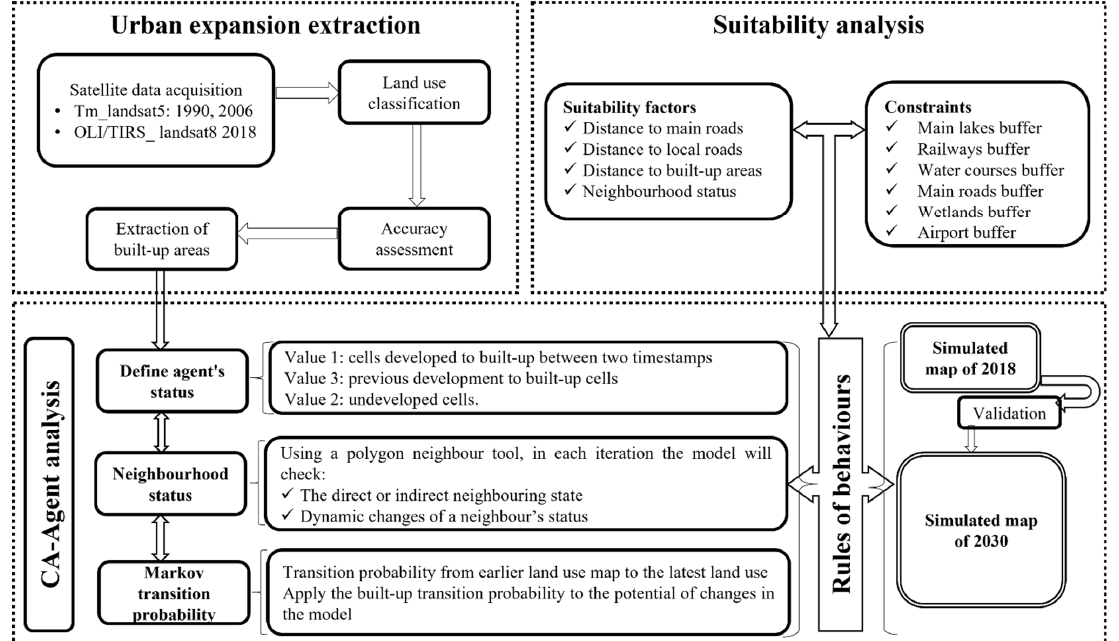
Figure 2. Methods for spatial data analysis and CA–Agent analysis.